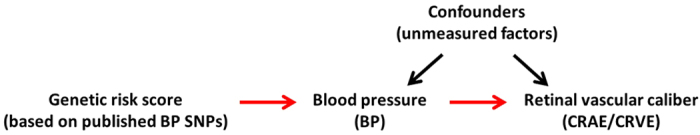
The theory of Mendelian randomisation by using BP genotype as an instrumental variable.